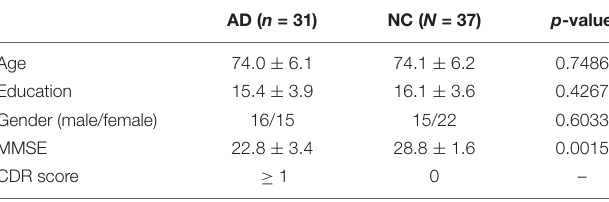
TABLE 1 | Demographic information of experimental